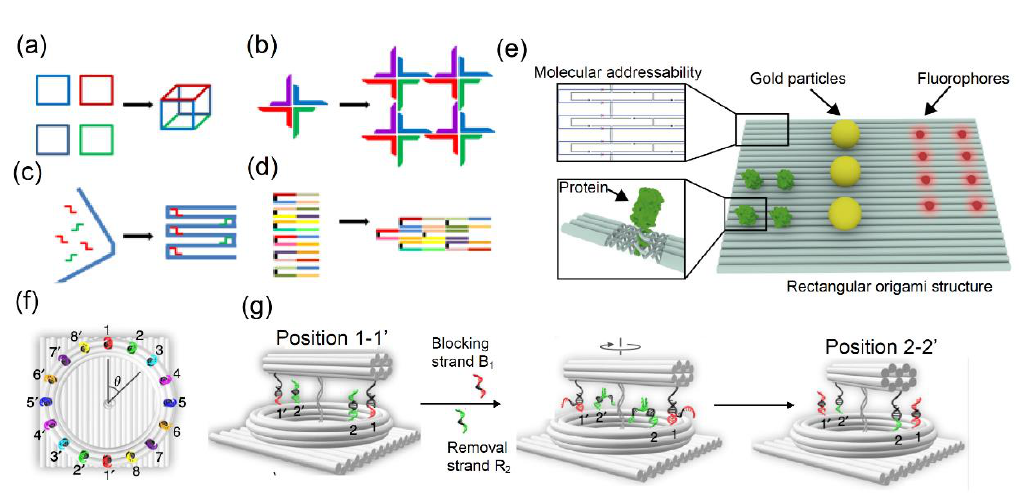
Figure 1. Di ff erent concepts of DNA assembly: ( a ) a finite-sized nanostructure; ( b ) DNA tiles assembled as a 4 × 4 2D square lattice, ( c ) sca ff old build based on long (blue) and short (red and green) DNA oligonucleotides, ( d ) DNA bricks constructed by short oligonucleotides, and ( e ) DNA nanostructures comprising di ff erent molecules such as protein (green), gold particles (yellow), or fluorophores (red). Top left: Detailed illustration of staple and sca ff old strands. Bottom left: Specific sequence-expanded staple strands. ( f ) Foothold arrangement around the ring tracks eight di ff erent colors of stepwise plasmonic nanoclock rotation steps corresponding to ∆ θ = π / 8. ( g ) The principle is based on the release and capture mechanism powered by the interaction between DNAzyme and RNA in a stepwise rotation with additional blocking strands and removal strands by toehold-mediated strand displacement reactions. Images ( a – d ) were reproduced with permission from Gradišar et al., published by BioMed Central, 2014 [18], ( e ) was reproduced with permission from Schlichthaerle et al., published by Elsevier, 2016 [23], and ( f , g ) were reproduced with permission from Xin et al., published by Nature Publishing Group, 2019 [22].